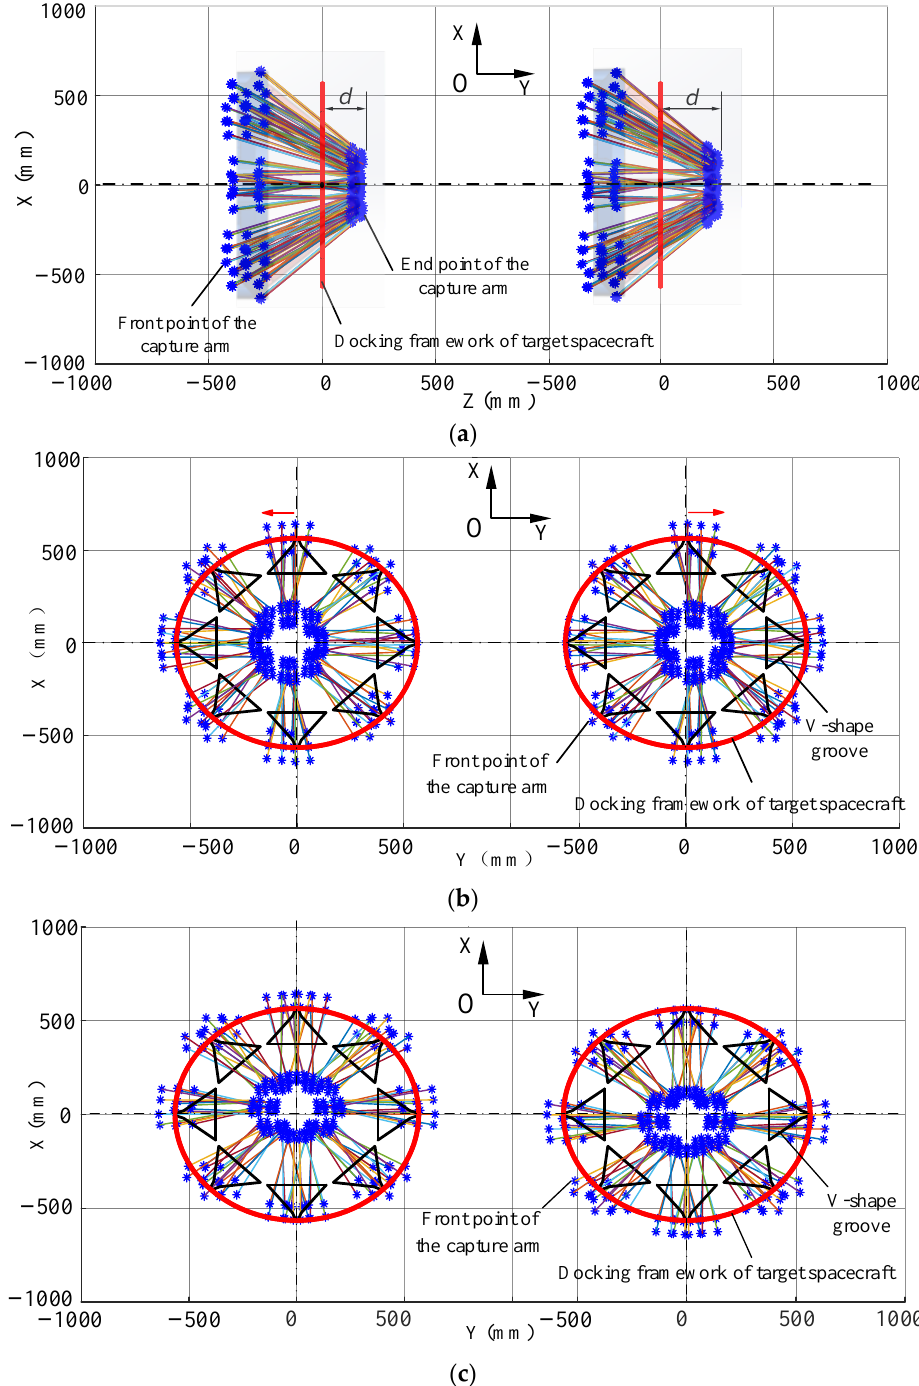
Figure 5. Error of position and posture: ( a ) Only variation of z variation of y i